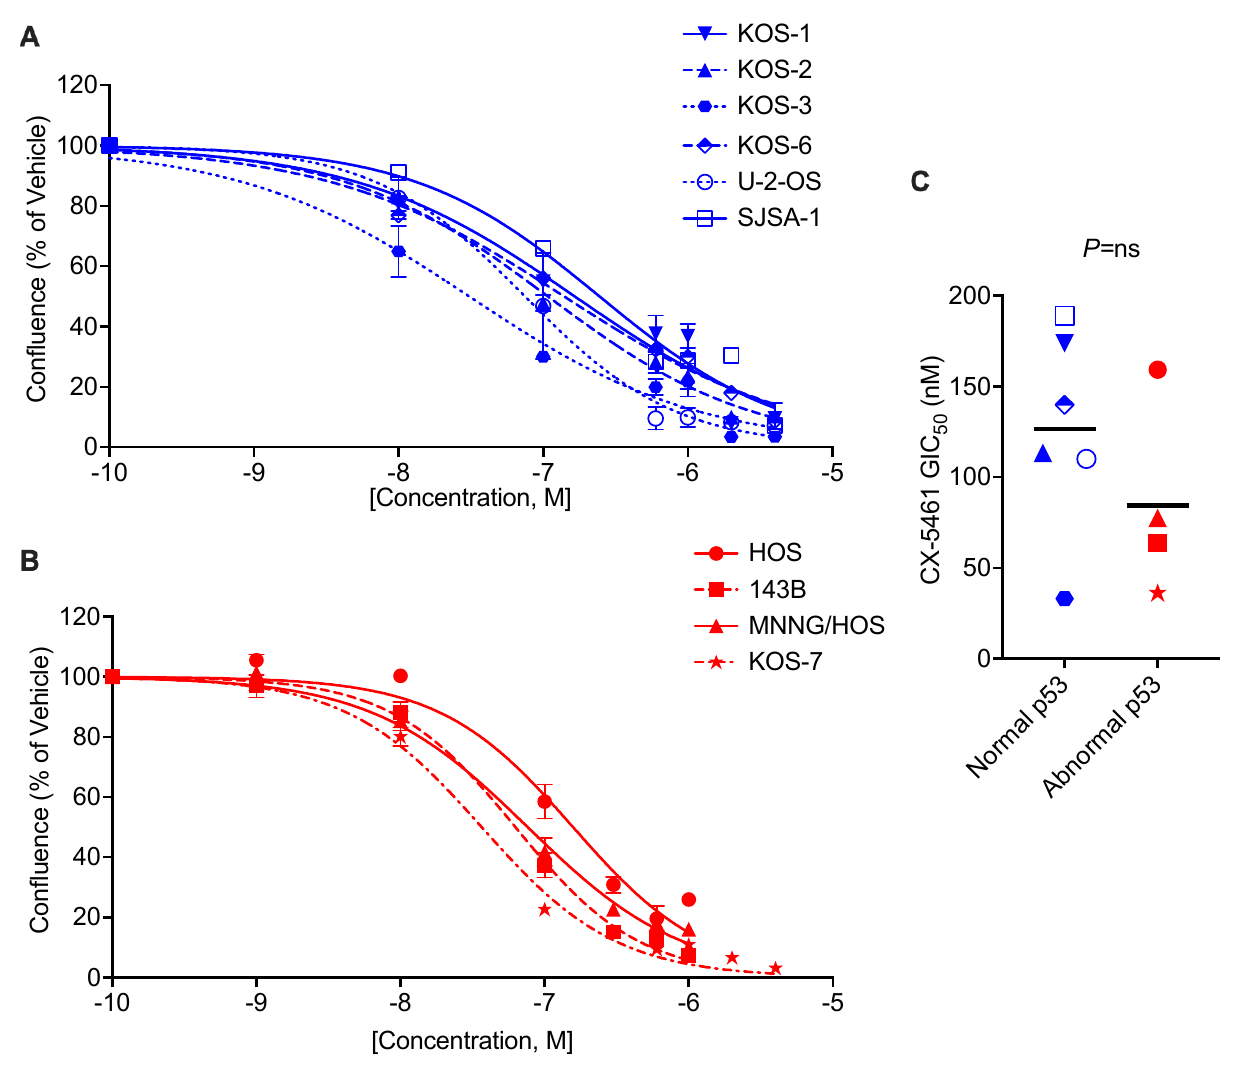
Figure 1. CX-5461 inhibits human OS cell proliferation irrespective of p53 status. ( A ) Normal p53 and ( B ) abnormal p53 osteosarcoma cell lines were treated with the indicated concentrations of CX-5461 or vehicle (50 mM NaH 2 PO 4 (pH 4.5)) for 72 h and assessed for proliferation using the IncuCyte ® ZOOM Live Cell Imaging System. Dose–response curves and 50% growth inhibitory concentrations (GIC 50 ) were calculated using non-linear regression analysis, mean +/ − SEM of n = 3 biological replicates. ( C ) Effect of p53 status on GIC 50 of CX-5461 with p53 status determined from genomic profiling data (Supplementary Table S1) and p53 protein expression levels in Western blots (Supplementary Figure S1). Normal p53: TP53 wild type with the normal level of p53 protein expression; abnormal p53: TP53 mutant or a dysregulated level of p53 protein expression. Each symbol represents the mean value of n = 3. Statistical analysis was conducted using a Mann–Whitney U test.